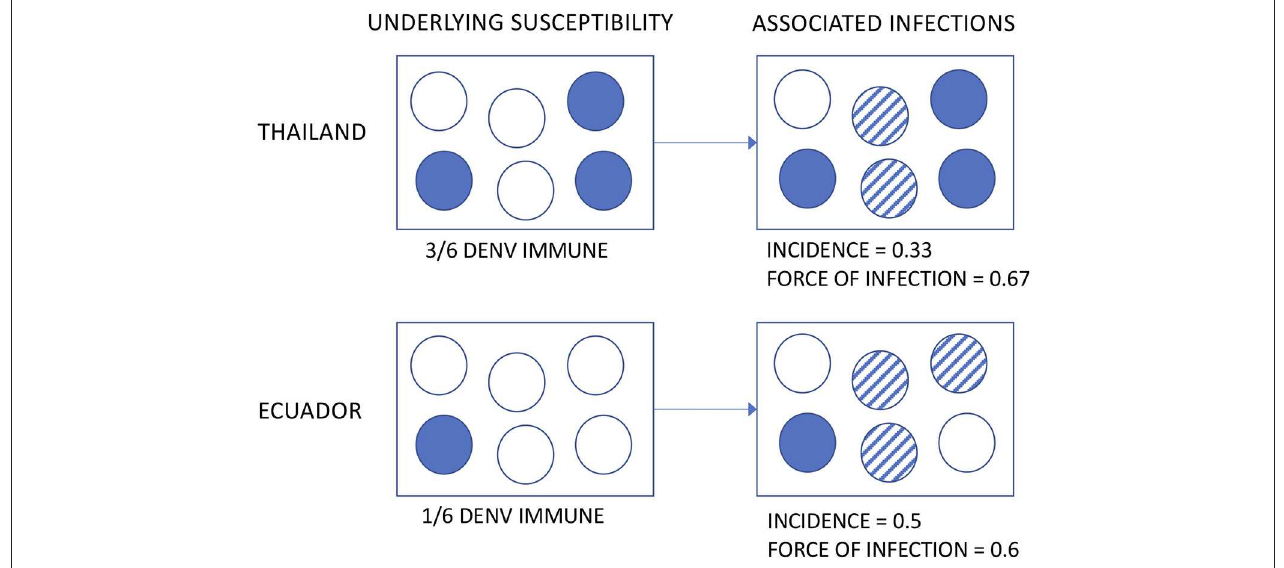
FIGURE 6 | Hypothetical illustration of the possible relationships between underlying susceptibility to DENV, observed incidence, and force of